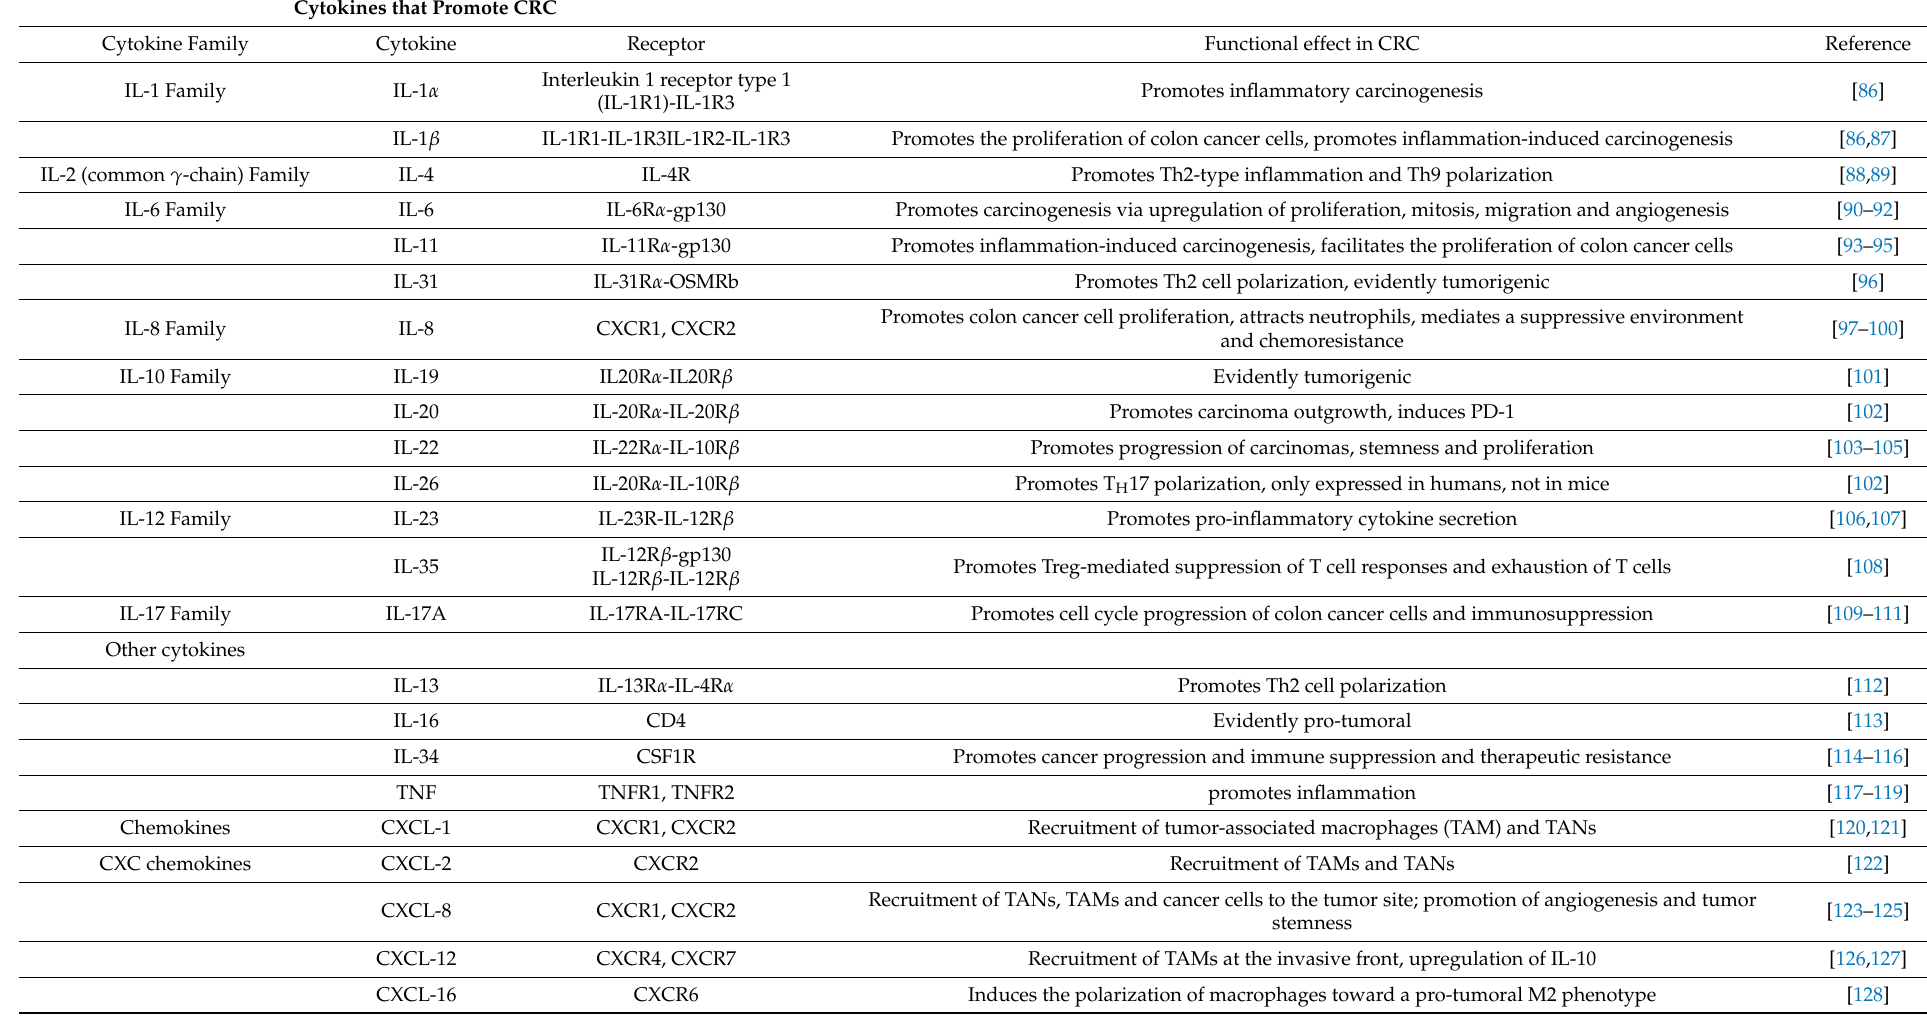
Table 1. Cytokines in colorectal